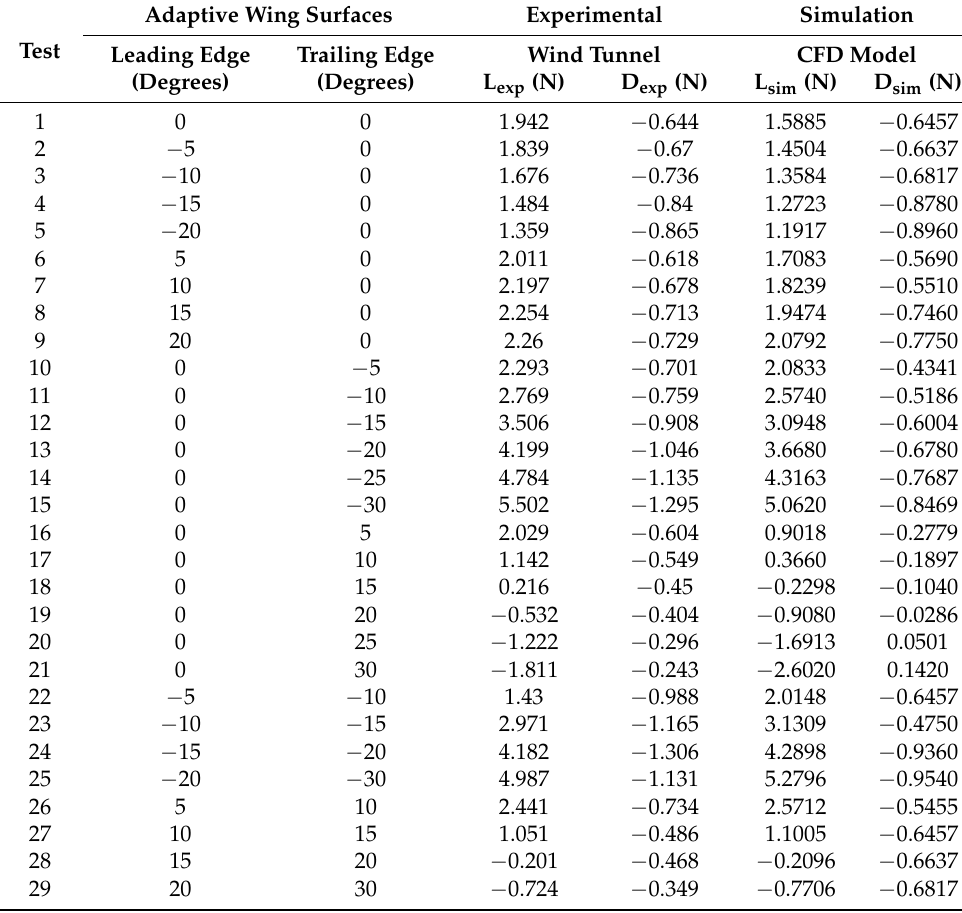
Table 9. Experimental and simulated data of the adaptive wing